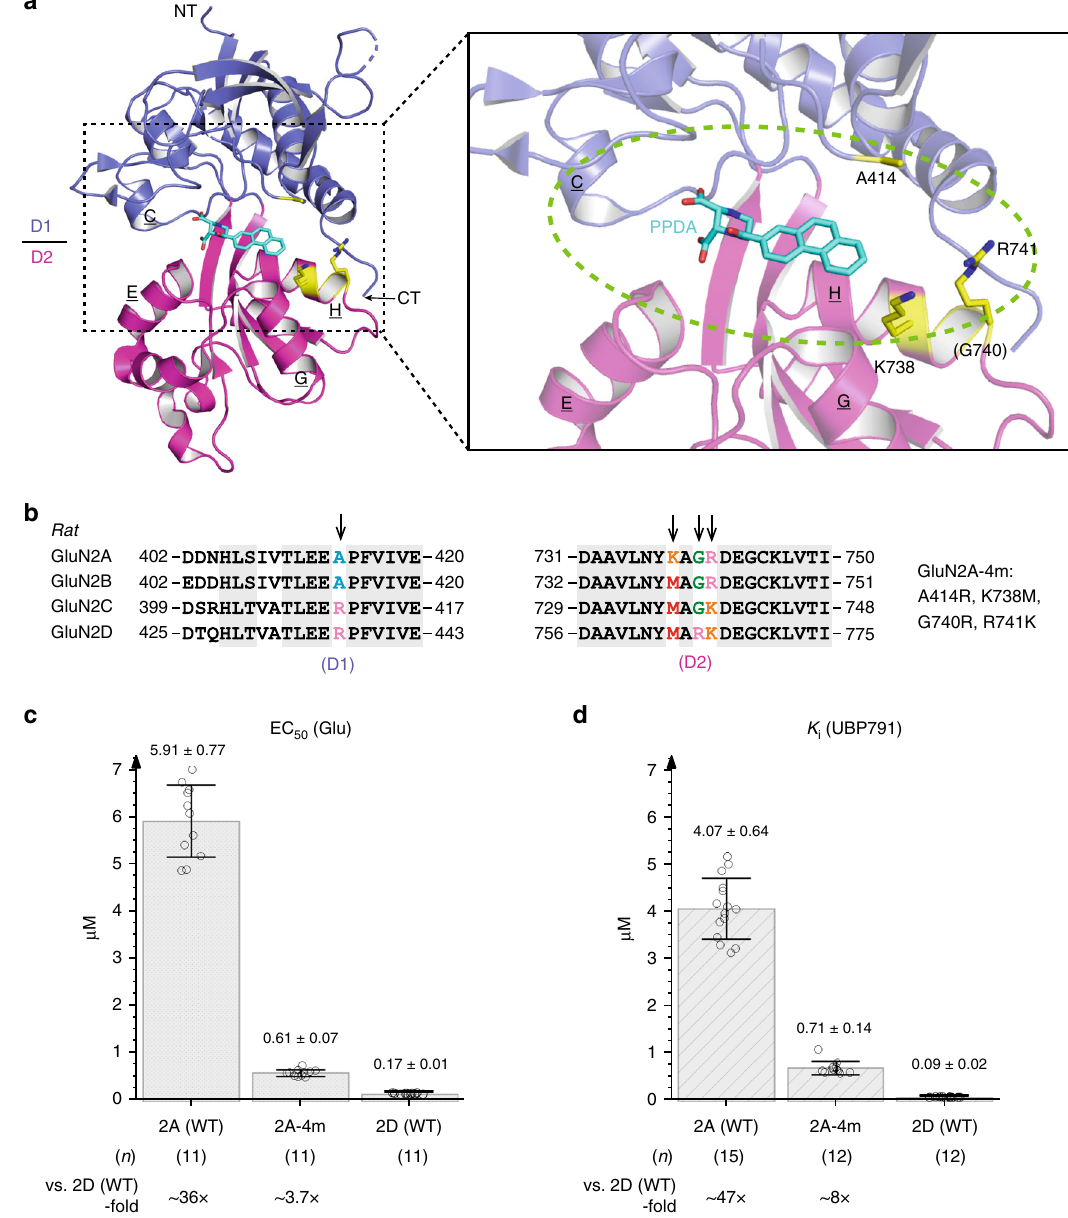
Fig. 3 Site-directed mutagenesis of GluN2A binding pocket and its effect on L -glutamate and UBP791 sensitivity. a, b The GluN2A LBD of the GluN1 – GluN2A LBD crystal structure complexed to PPDA (cyan sticks; PDB code: 4NF6) colored as in Fig. 1. Residues within the ligand-binding pocket (green dashed oval) which are not conserved among GluN2A-D in the sequence alignment (panel b arrows) are shown in yellow. Four mutations (Ala414Arg, Lys738Met, Gly740Arg, Arg741Lys) were introduced in GluN2A to generate GluN2A-4m. c EC 50 values for L -glutamate and d K i values for UBP791 for GluN1-4a/GluN2A-4m were obtained by TEVC. Dose-response for UBP791 was measured in the presence of 100 μ M glycine and 1 μ M L -glutamate with varying UBP791 concentrations (Supplementary Fig. 2). Single data points are shown as open circles, the bar graph represents the mean with error bars for s.d., and the number of recordings (n) and the fold-difference to EC 50 and K i of GluN2D are as shown. Pairwise comparison shows subtypes have different potencies ( p < 0.0001 with two-tail t -test and Bonferroni GluN2A-4m mutant indicated that the four residue positions in the binding cleft (Fig. 3a) are the major determinants of subtype- speci fi c ligand binding.